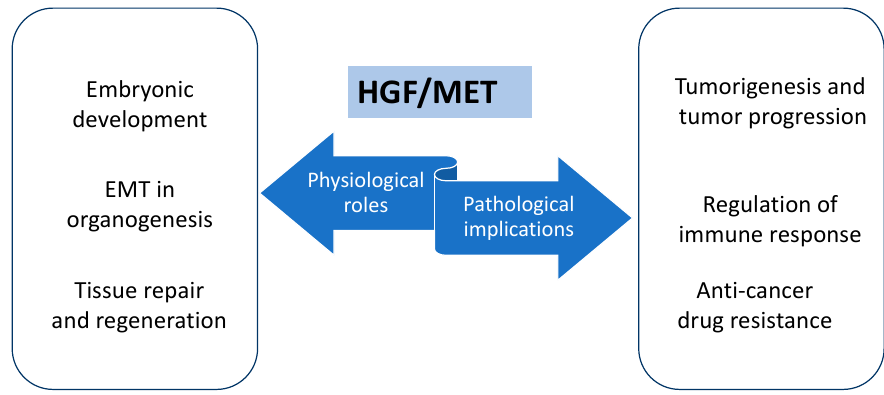
Figure 1. Roles of the hepatocyte growth factor (HGF)/mesenchymal-epithelial transition factor (MET) pathway.